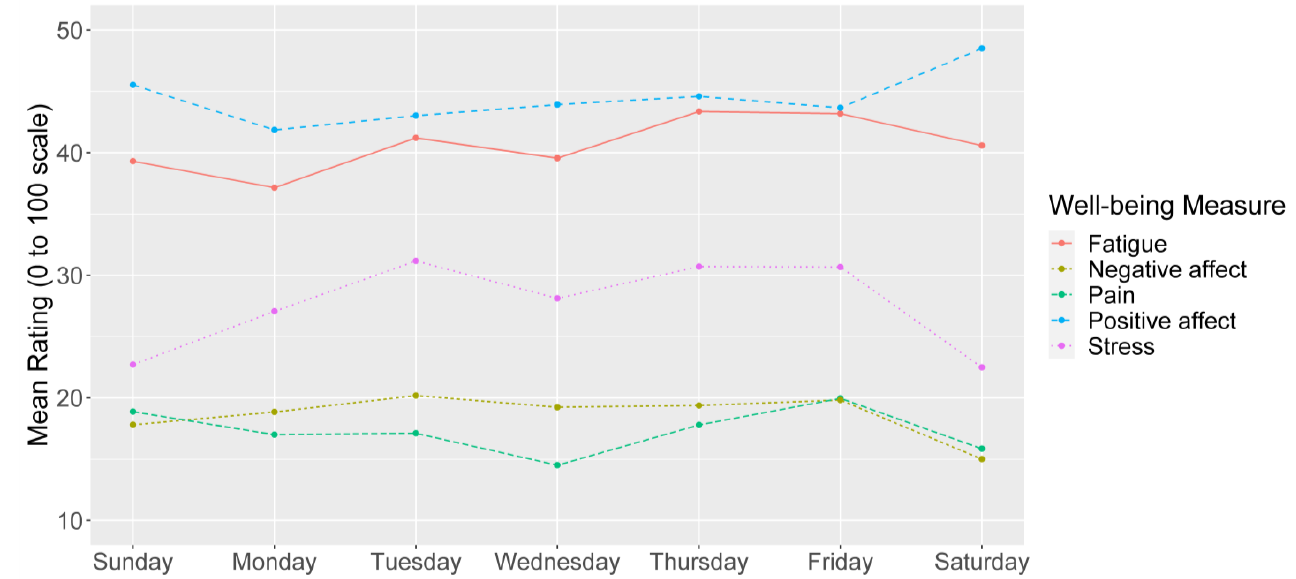
Figure 2. Average ratings of state-level well-being, by day of